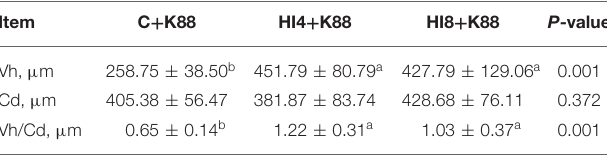
TABLE 7 | Effect of Hermetia illucens larvae on ileum morphology of piglets attacked by ETEC K88 ( n =